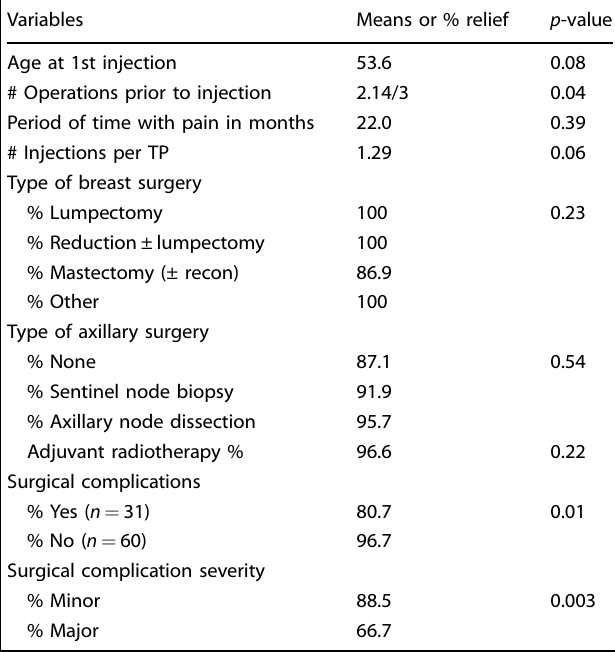
Table 3. Unadjusted comparisons between sample characteristics and primary